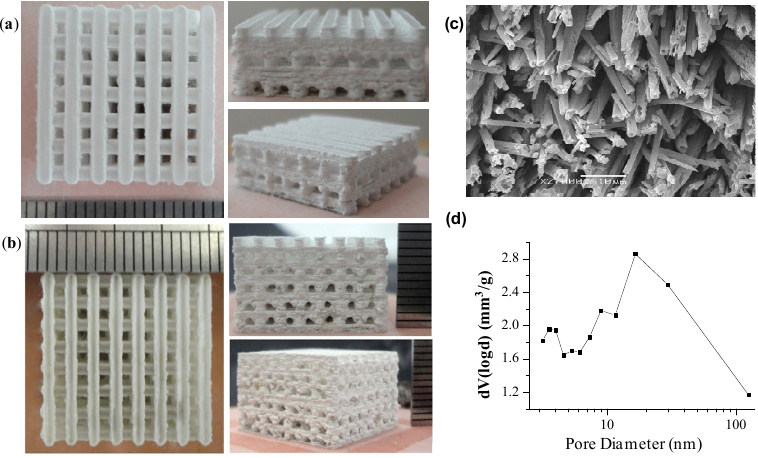
Figure 1. ( a , b ) Bioactive ceramic (TCP) scaffolds fabricated by SLS; ( c ) Micro/nanometer-sized porous morphology; and ( d ) Pore size distribution curve on the etched surface of HAP/TCP (60/40 w / w ) ceramic